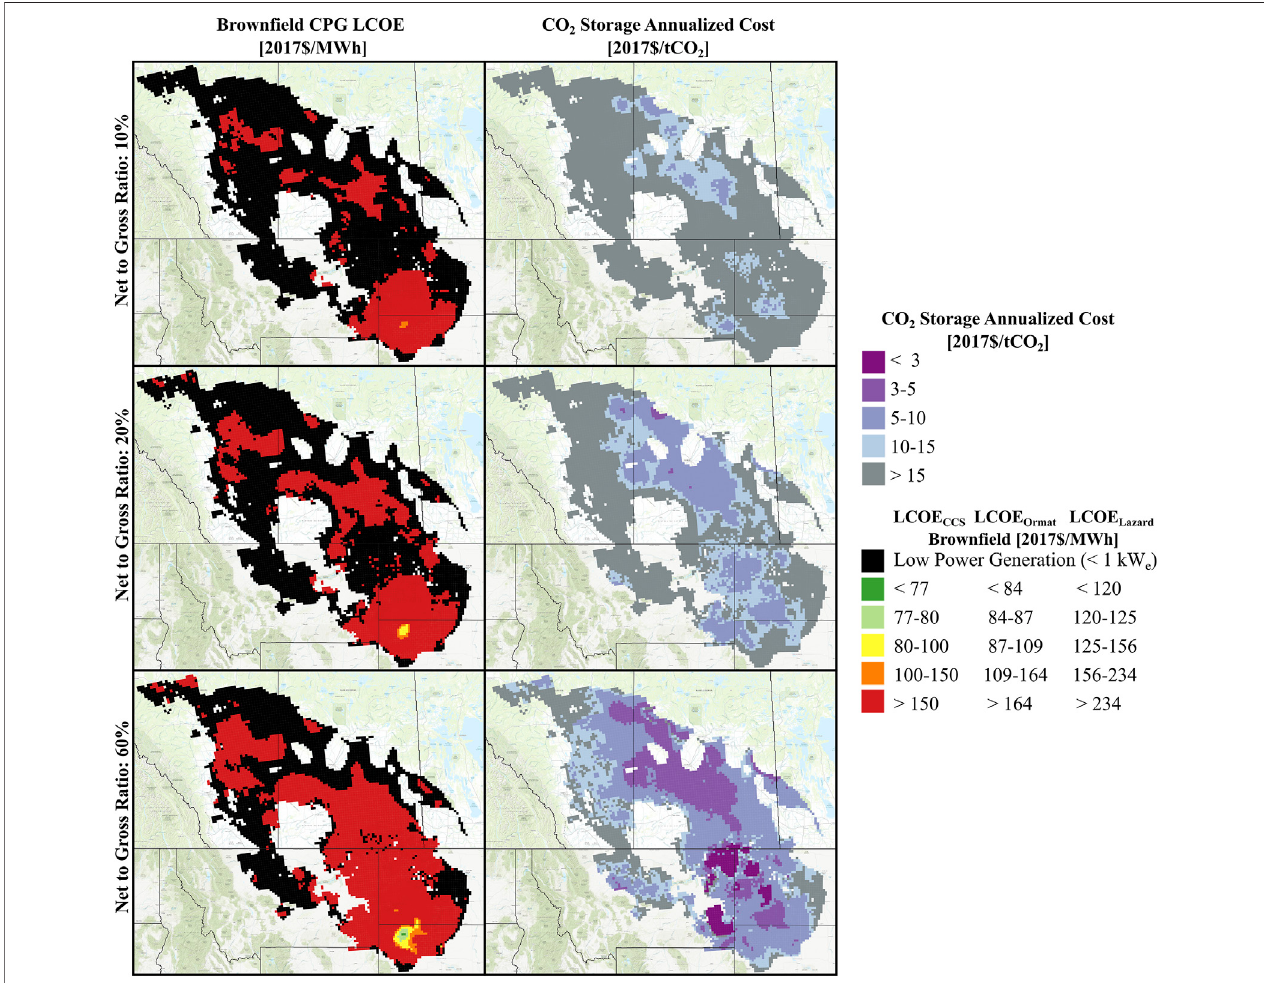
FIGURE2| GeospatialVariabilityinCostofCO 2 PlumeGeothermalPowerPlantsandCO 2 StorageAcrossthePCORArea.ForCPGmaps(leftcolumn),lowpower generation areas (black grid cells) are locations in which the power generation from one CPG power plant was less than 1 kW e .